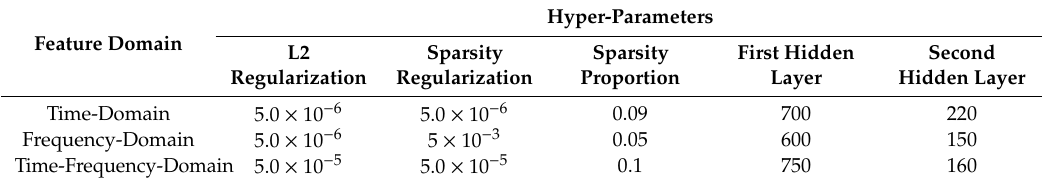
Table 2. Parameter used in Stacked-SAEs-based DNN for Current